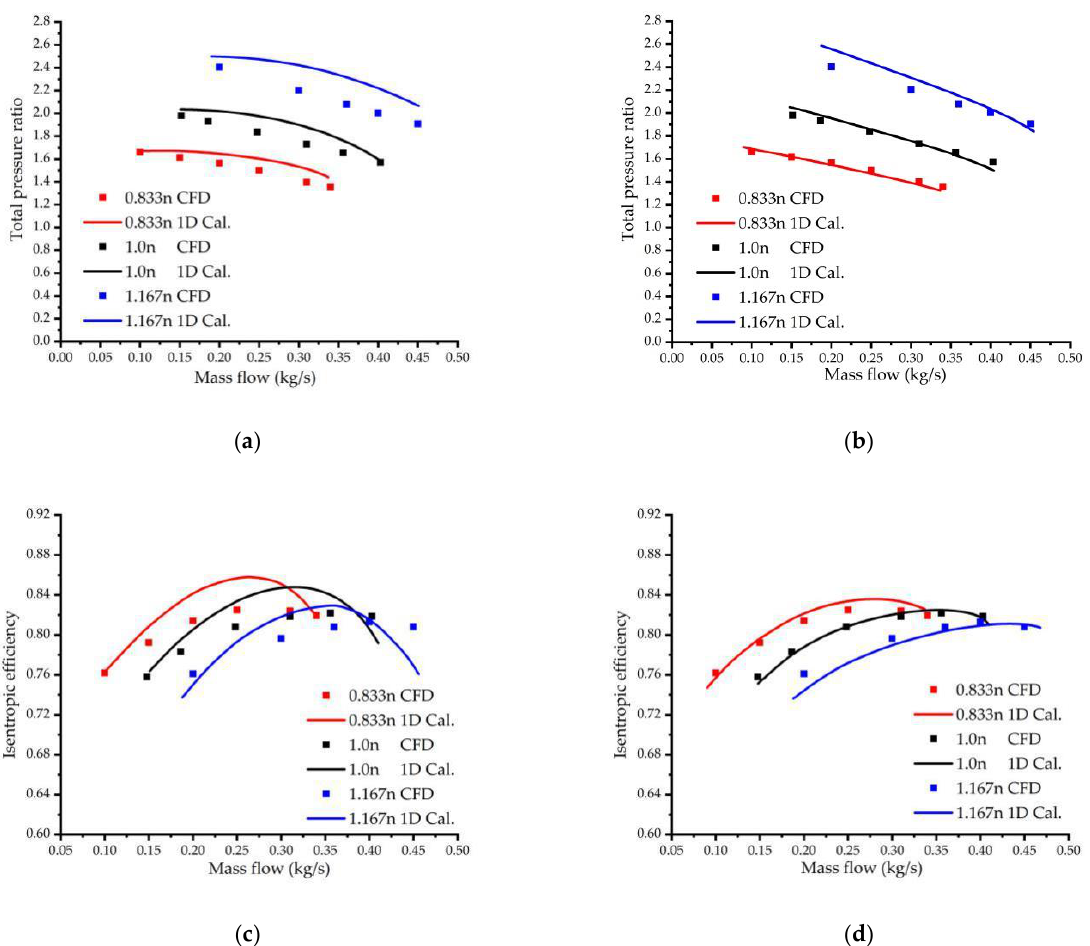
Figure 15. Comparisons of the 1D predicted performance before and after optimization for the R impeller: ( a ) Total pressure ratio before optimization; ( b ) Total pressure ratio after optimization; ( c ) Efficiency before optimization; ( d ) Efficiency after optimization.